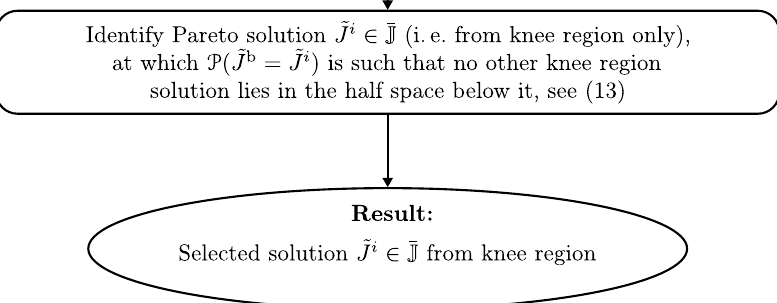
Figure 5. Flowchart diagram for the second step of the proposed decision making approach, i.e., the final selection of a solution from the knee